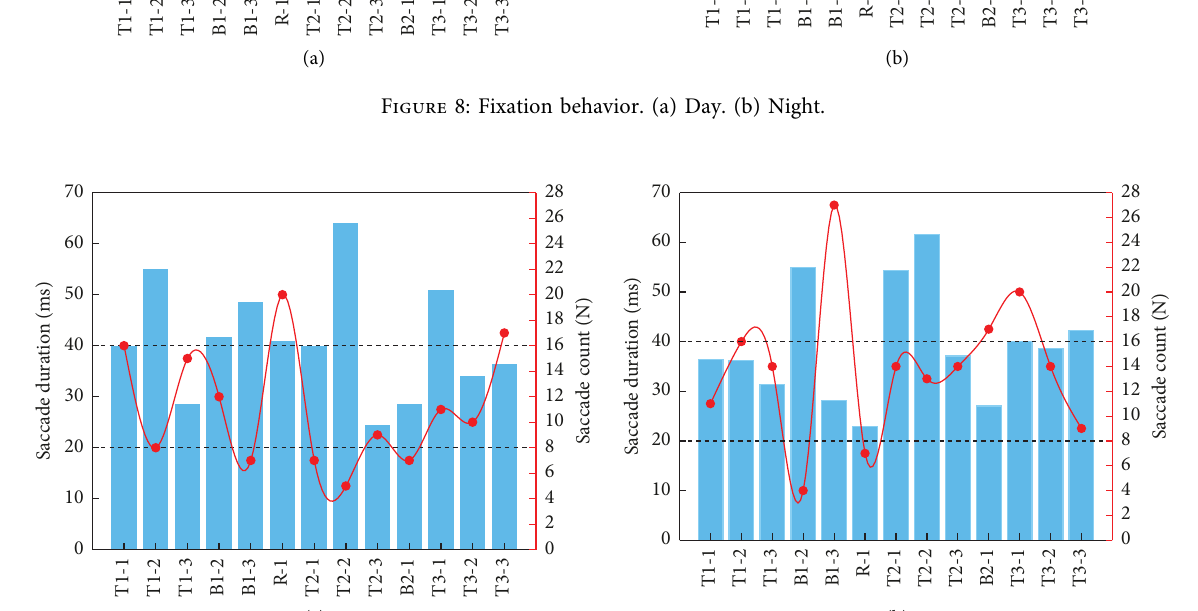
Figure 9: Saccades behavior. (a) Day. (b)